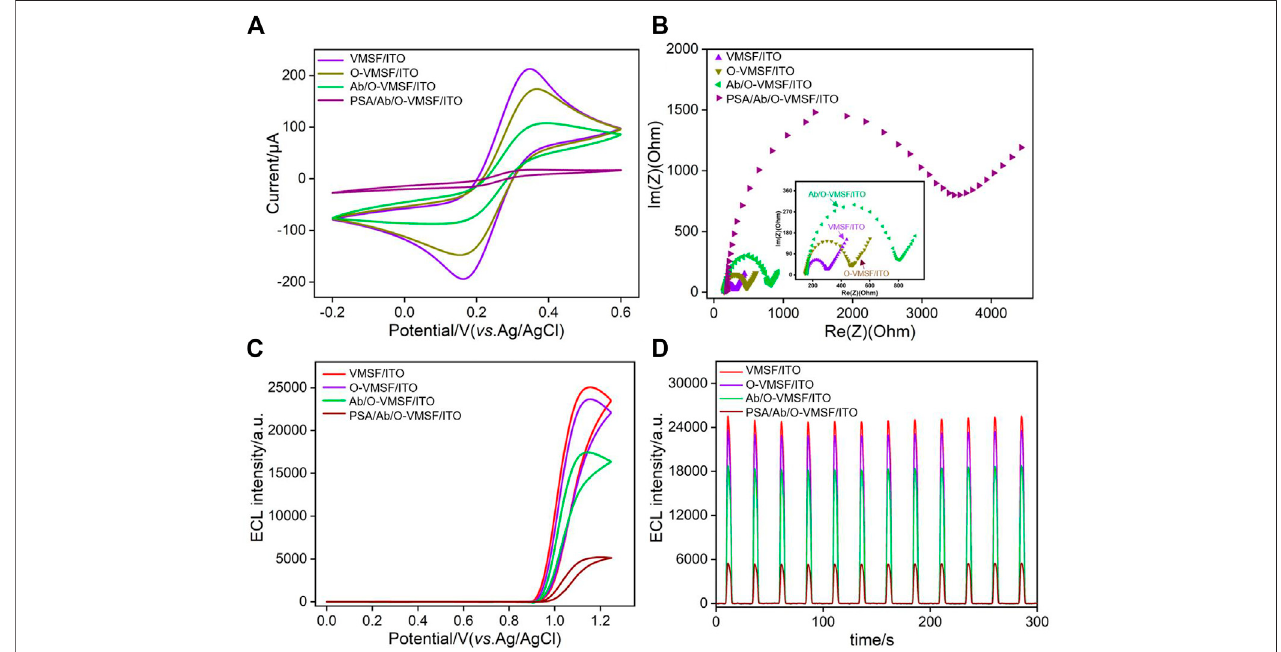
FIGURE4| Cyclicvoltammetriccurves (A) andNyquistplots (B) recordedondifferentelectrodesin5 mMK 3 [Fe(CN) 6 ]/K 4 [Fe(CN) 6 ](1:1)containing0.1 MKCl.ECL intensity-potential curves (C) and ECL intensity-curves (D) obtained on different electrodes.